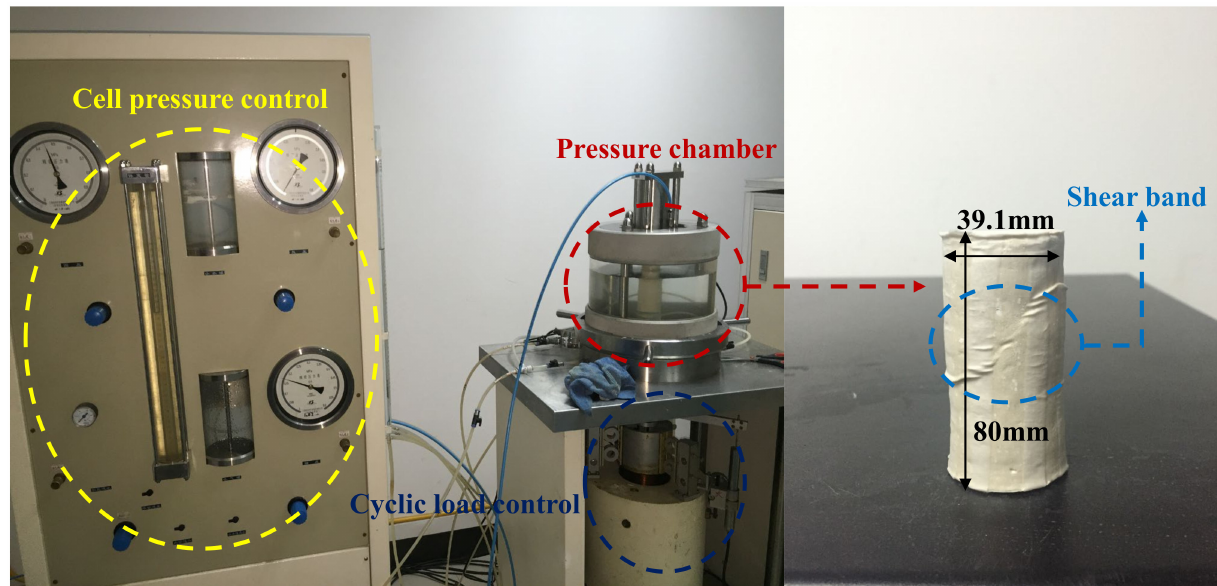
Figure 5. Experimental apparatus (DDS-70) and typical specimen diagram.